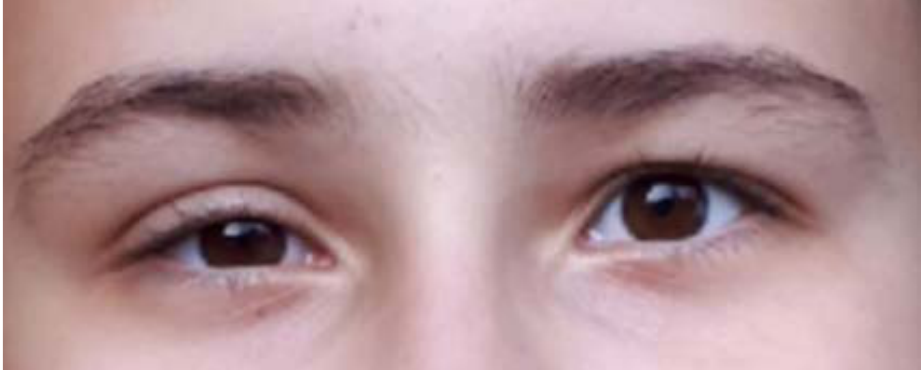
Figure 1. Right Horner syndrome after total thyroidectomy and lateral and central neck for medullary thyroid carcinoma.